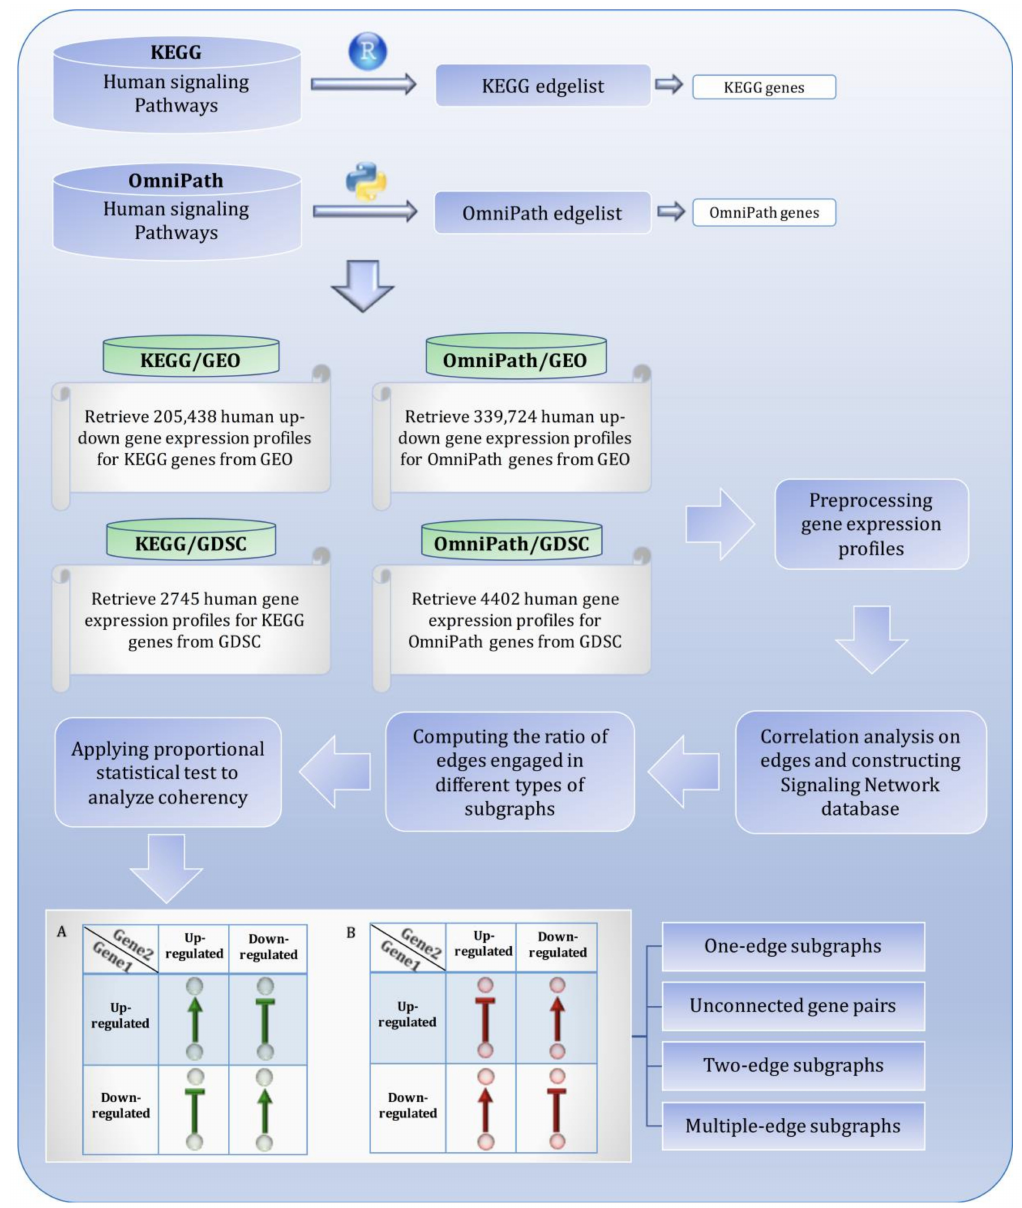
Figure 1. Visual overview of how information from di ff erent databases was integrated to analyze the coherency. An edge list was constructed from Kyoto Encyclopedia of Genes and Genomes (KEGG) and OmniPath databases. All the gene expression profiles for the edge list genes were then downloaded from Gene Expression Omnibus (GEO) and Genomics of Drug Sensitivity in Cancer (GDSC) databases. Next, data were preprocessed, and a suitable structure was created for correlation analysis among the gene pairs. By interpreting the information from correlation tests and the proportional tests, coherency analysis was implemented on di ff erent forms of subgraphs. There are a total of four coherent conditions in panel A and four incoherent conditions in panel B. For instance, in panel A, if gene1 is up-regulated and there is an activation between the gene pair, gene2 must be up-regulated. In panel B, if gene1 is up-regulated and there is an inhibitory relationship between the gene pair, gene2 is expected to be